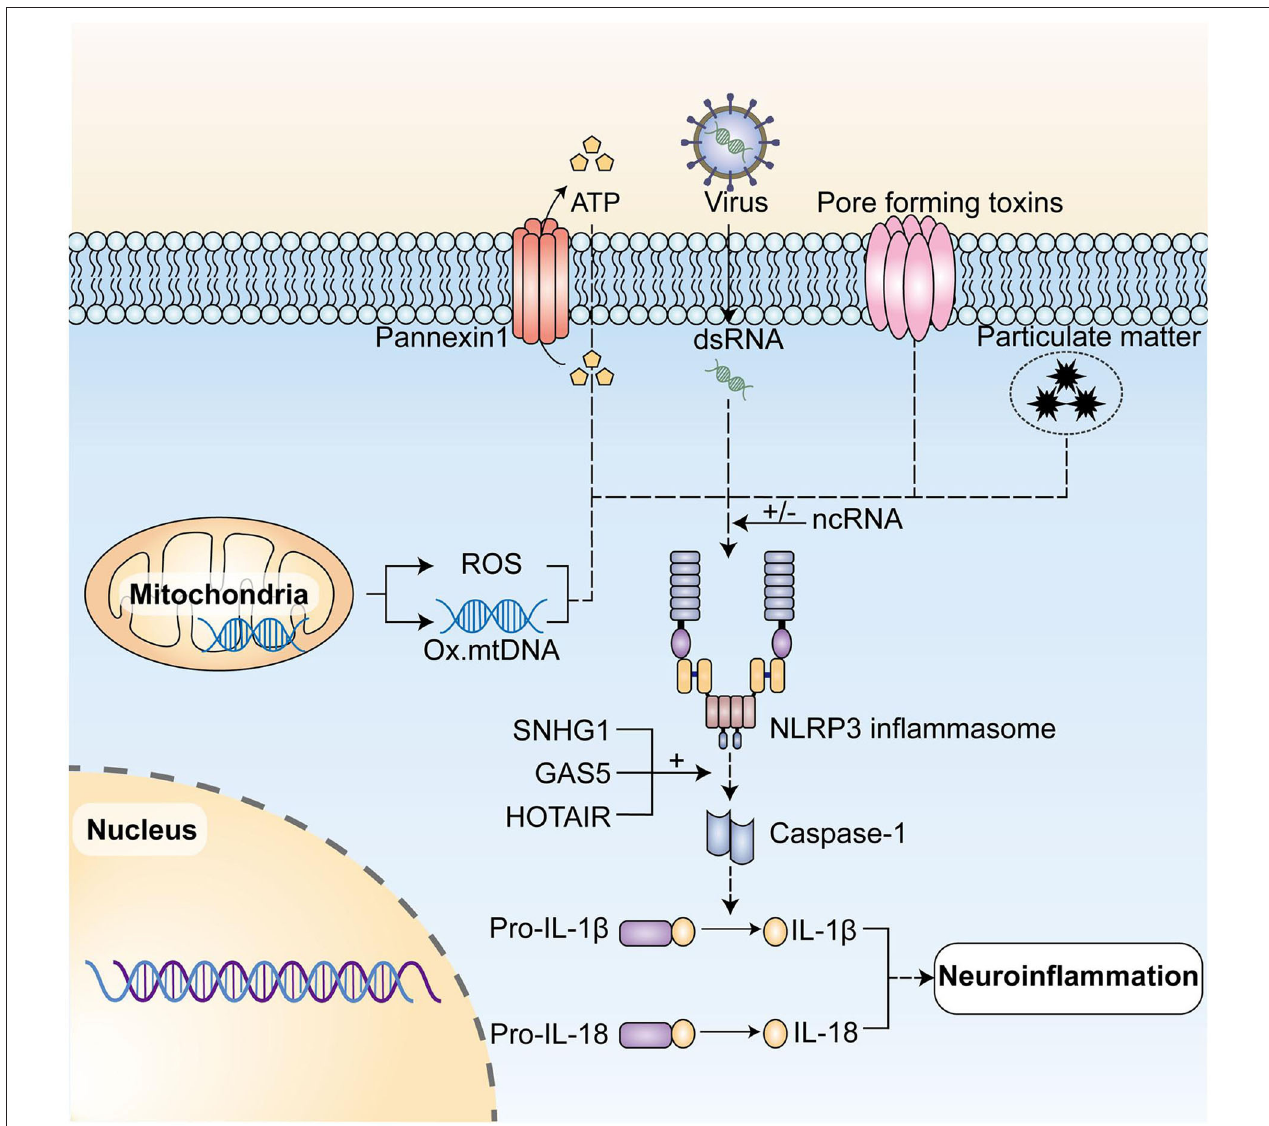
FIGURE 2 | NcRNAs play a regulatory role in the activation of NLRP3 inflammasome and its post-translational modification. The NLRP3 inflammasome initiates, activates, and then posttranslational modifications under the action of initiating signals, including dsRNAs of RNA viruses, and activation signals, such as extracellular ATP, pore-forming toxins, particulate matter, mtDNA, and ROS produced by mitochondria and so forth, leading to the caspase-1 activation. In turn, it mediates the production of pro-inflammatory cytokines such as IL-1 β and IL-18, and ultimately initiates neuroinflammation. NLRP3, NLR family pyrin domain containing 3; mtDNA, mitochondrial DNA; ROS, reactive oxygen species. LncRNA SNHG1, lncRNA GAS5, and lncRNA HOTAIR can play a regulatory role by up-regulating NLRP3 expression.